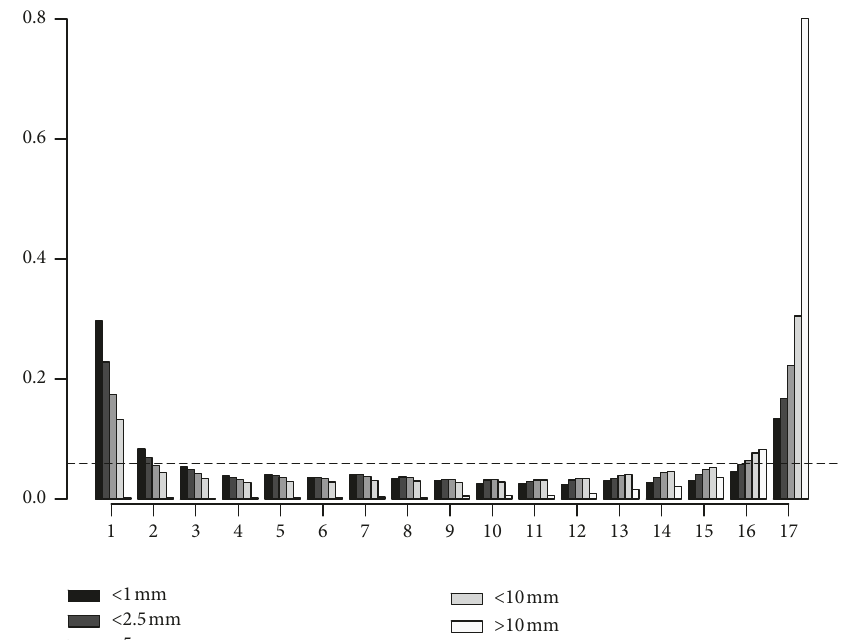
Figure 6: Rank histogram for ensemble forecast (ALADIN-LAEF). Bins decomposition is based on 6 h rainfalls < 1mm (black bars), < 2.5mm, < 5mm, < 10mm, and > 10mm (white